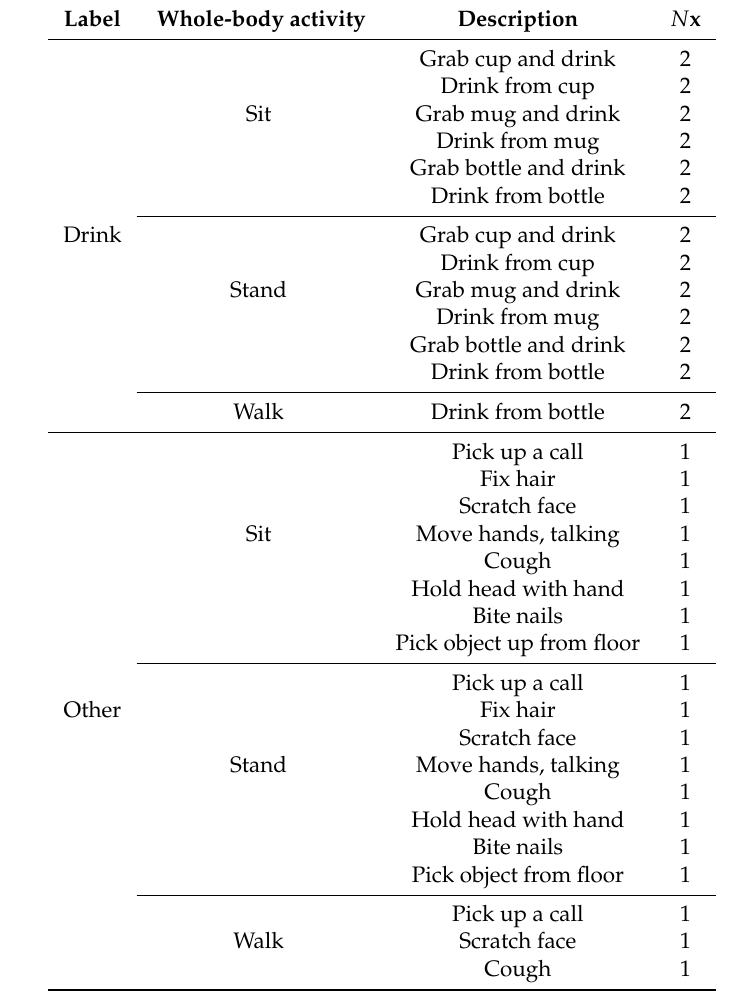
Table 1. Activities performed by each subject during data collection. N x is the number of